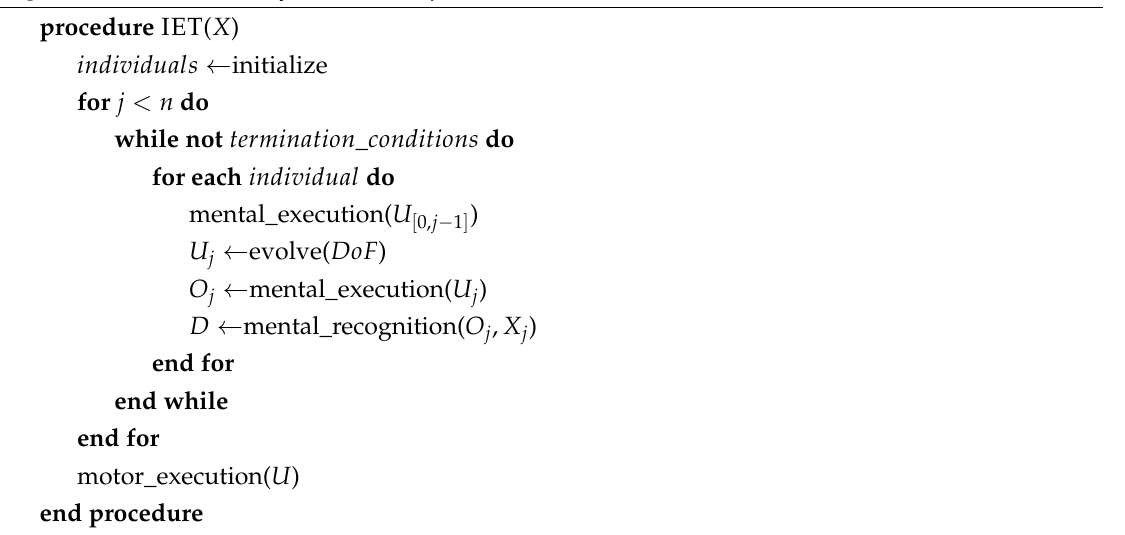
Algorithm 1 Incrementally Evolved Trajectories